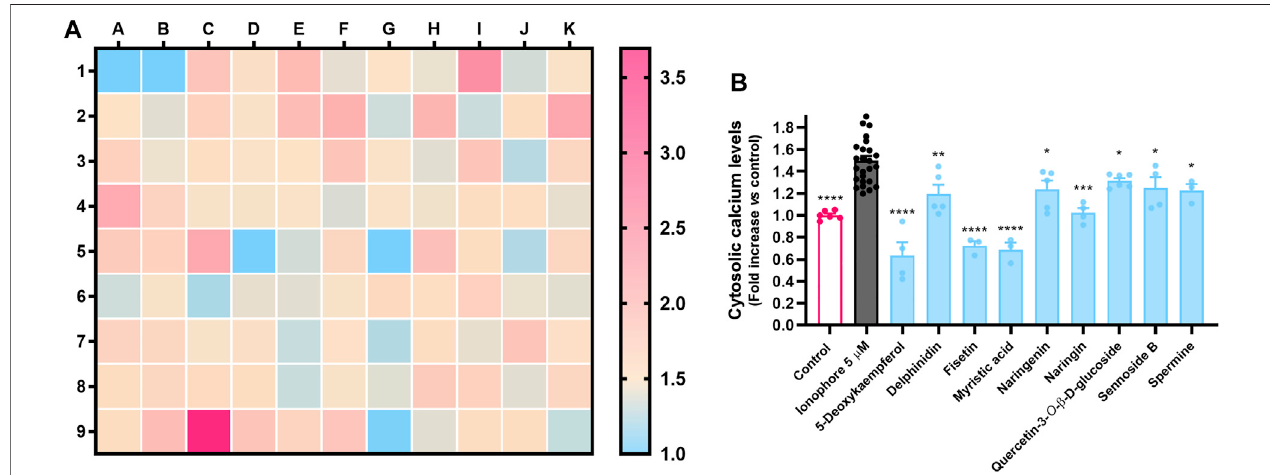
FIGURE 3 | Cytosolic calcium levels in MRC-5 fi broblasts in response to co-incubation of calcium ionophore A23187 at 5 µM and nontoxic molecules (50 µM), as determined by the fl uorescence of the probe Fura-2/AM. (A) Heatmap representing all molecules tested; (B) Molecules that caused a statistically signi fi cant decrease in calcium levels when compared to the positive control. Results correspond to the mean of, at least, three independent experiments, each performed in